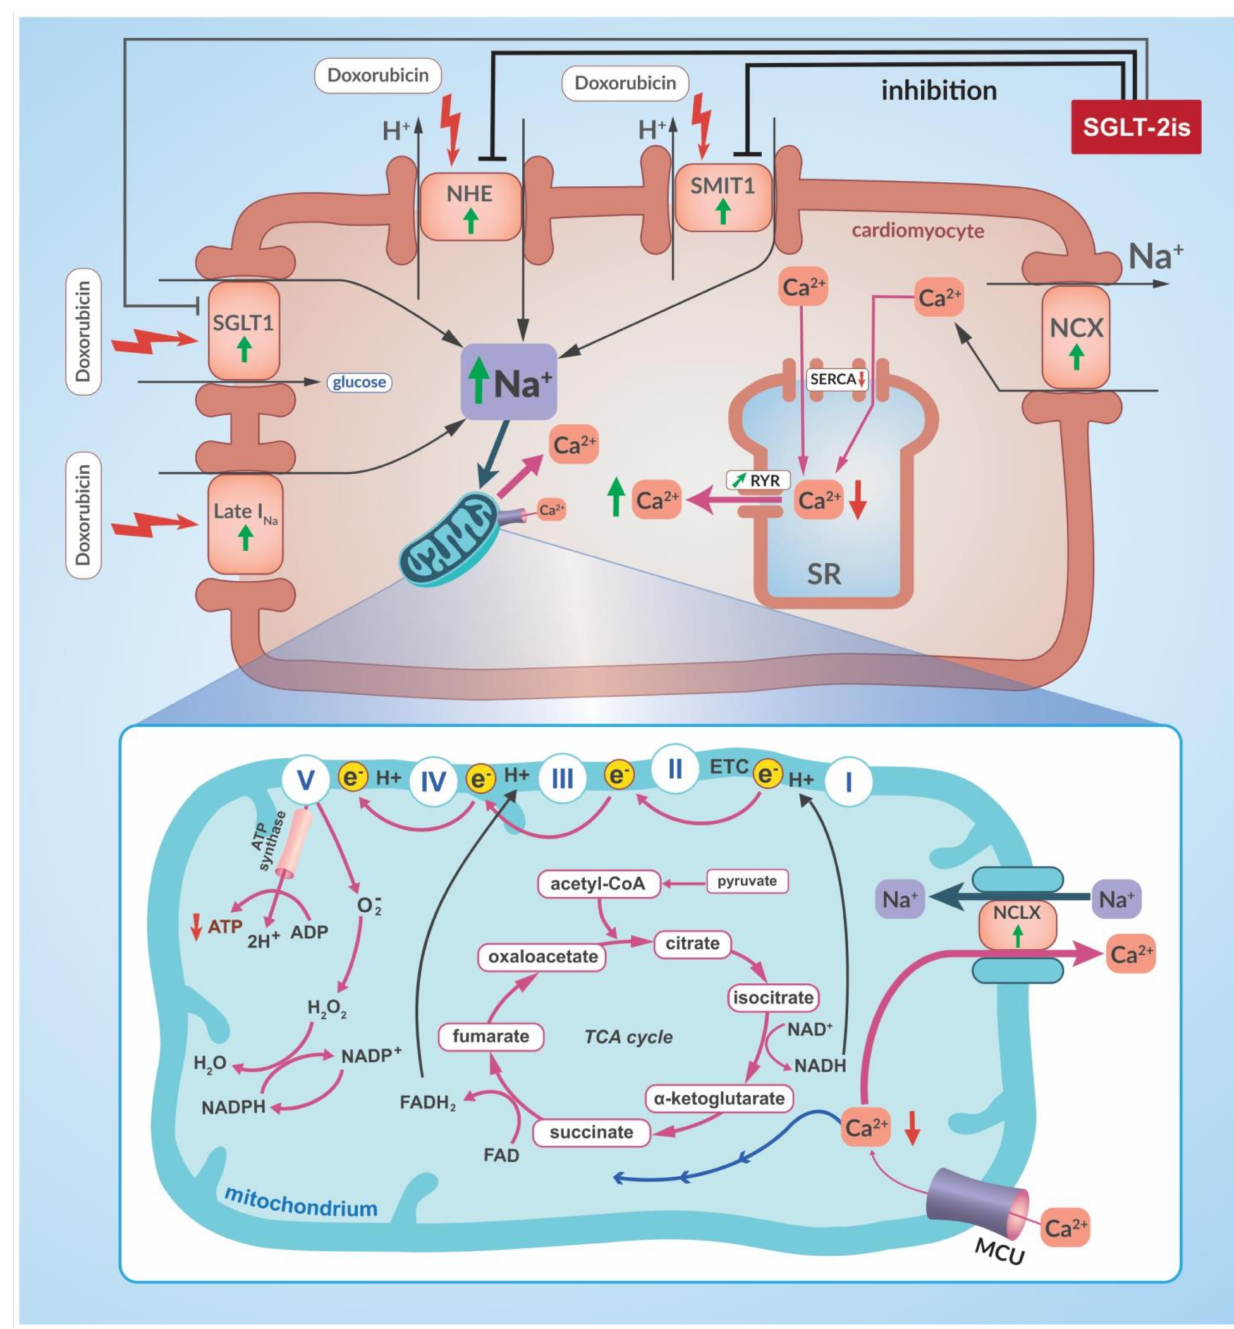
Figure 4. SGLT-2 inhibitors inhibit the cardiotoxic action of doxorubicin. SGLT-2 inhibitors